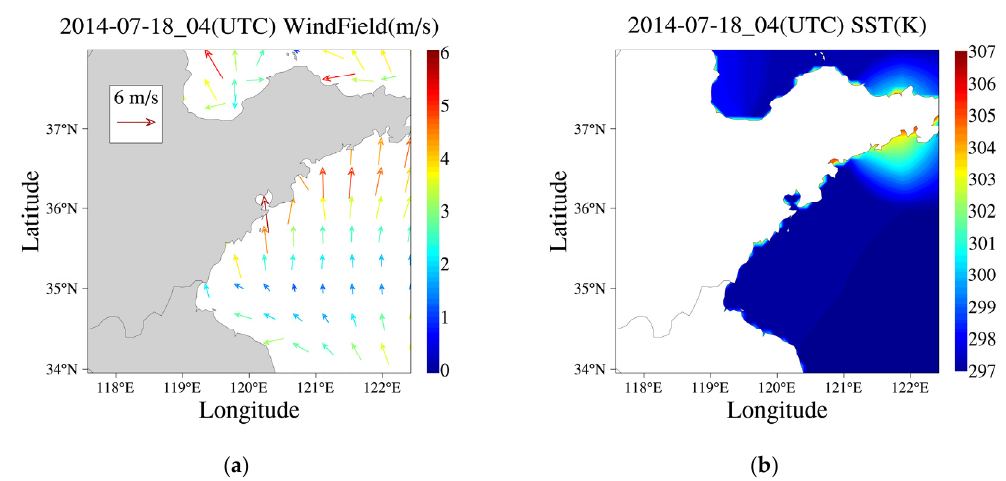
Figure 9. Regional distributions of the wind field and sea surface temperature (SST): ( a ) wind field (m/s); ( b ) SST (K).